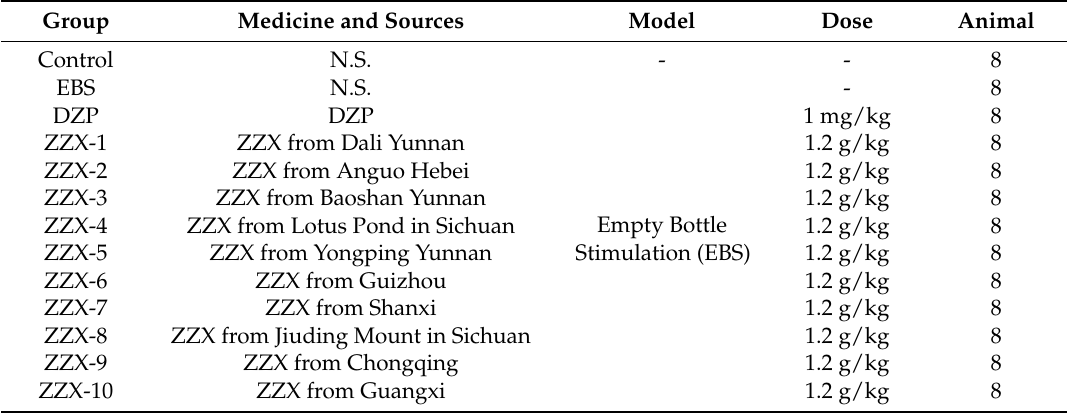
Table 6. Experimental groups and procedure. Group Medicine and Sources Model Dose